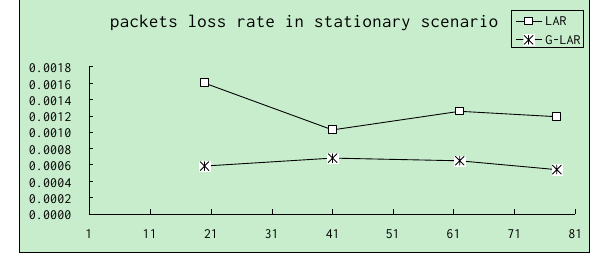
Fig. 11. Packets loss rate in stationary scenario packets loss rate in mobile scenario